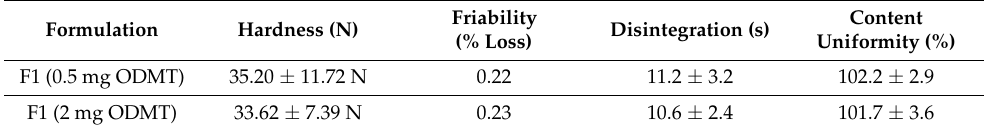
Table 6. Tablet properties. Hardness value and disintegration time presented as mean ± standard deviation ( n = 3). Content uniformity presented as mean ± standard deviation ( n =